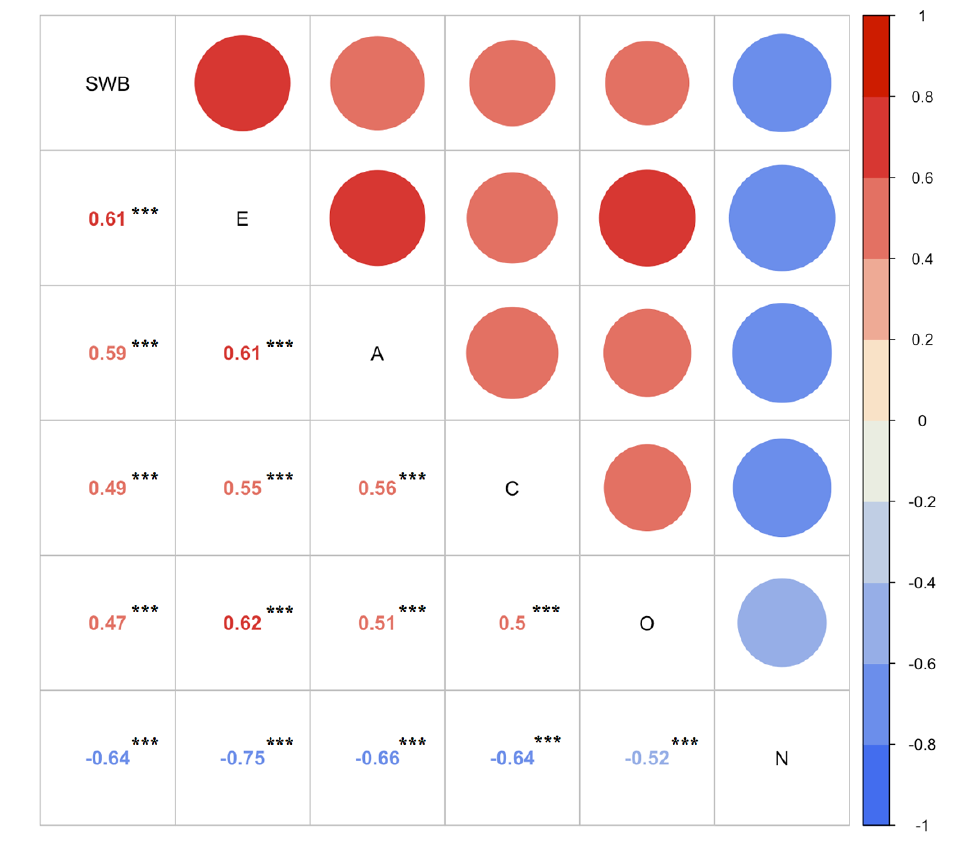
Figure 2. Heat map illustrating correlations between personality traits and subjective well-being The values in the lower triangular matrix is correlation coefficients (Pearson’s r ). In the upper triangular matrix, big circles in dark colors indicates strong correlations. Positive correlations are showed in red while negative correlations are showed in blue. The asterisks show the significant levels.